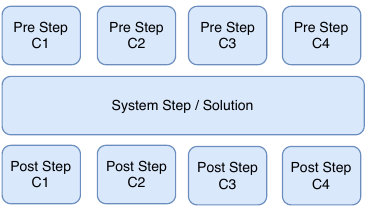
Figure 5. Parallelization of the component step calculations.